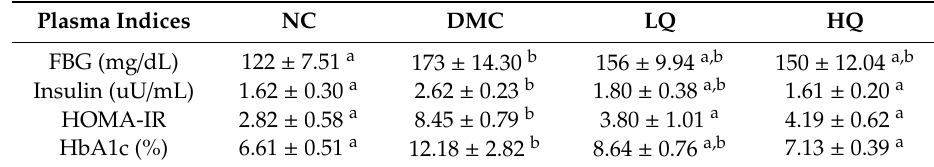
Table 3. E ff ect of QAE on plasma indices related to type 2 diabetes.